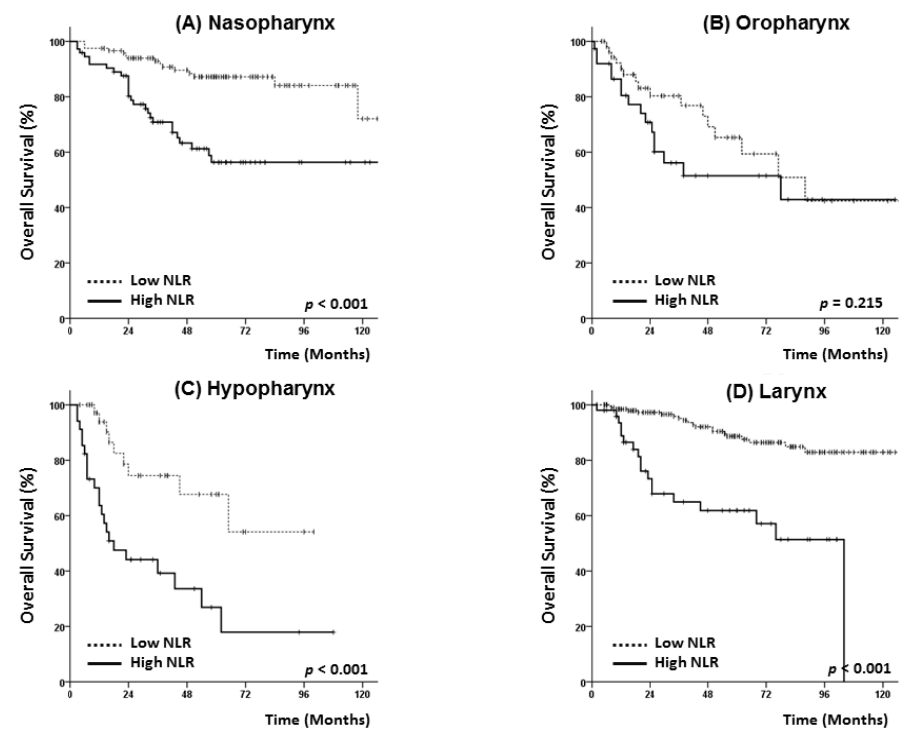
Figure 4. Subgroup analysis of overall survival according to primary tumor site: nasopharynx ( A ), oropharynx ( B ), hypopharynx ( C ) and larynx ( D ).